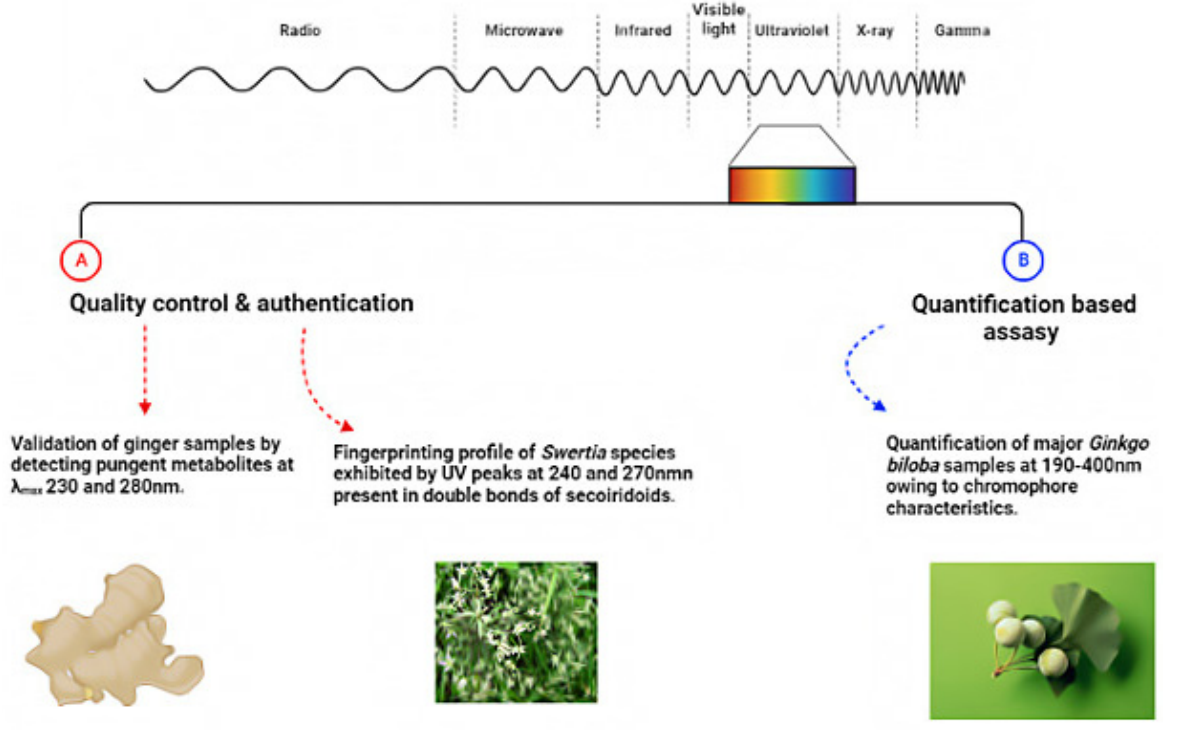
Figure 3. Quality control ( A ), qualitative/quantitative ( B ), of UV spectroscopy in the nutraceuticals